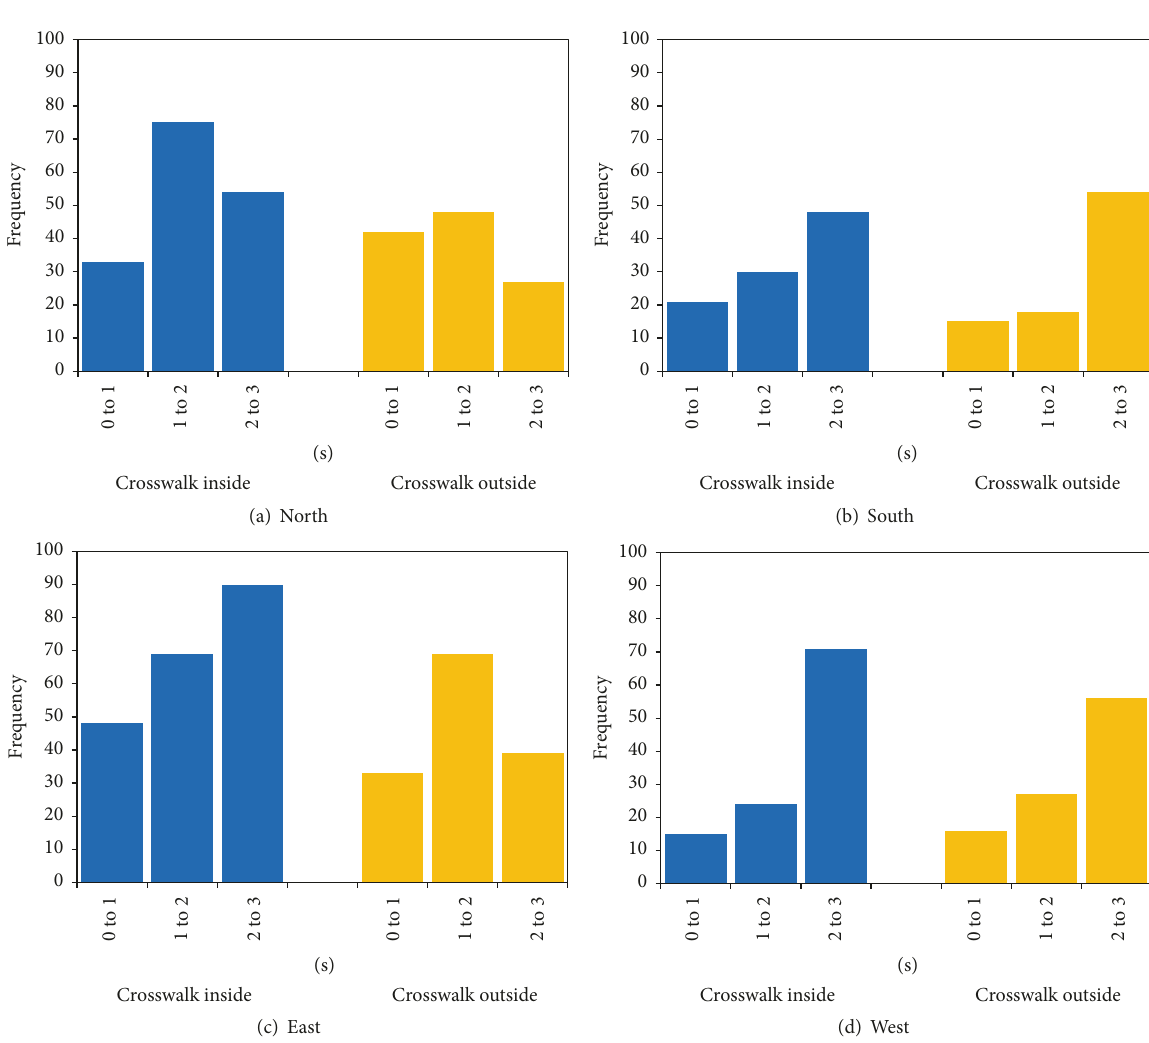
Figure 11: The number of small PETs inside and outside of the